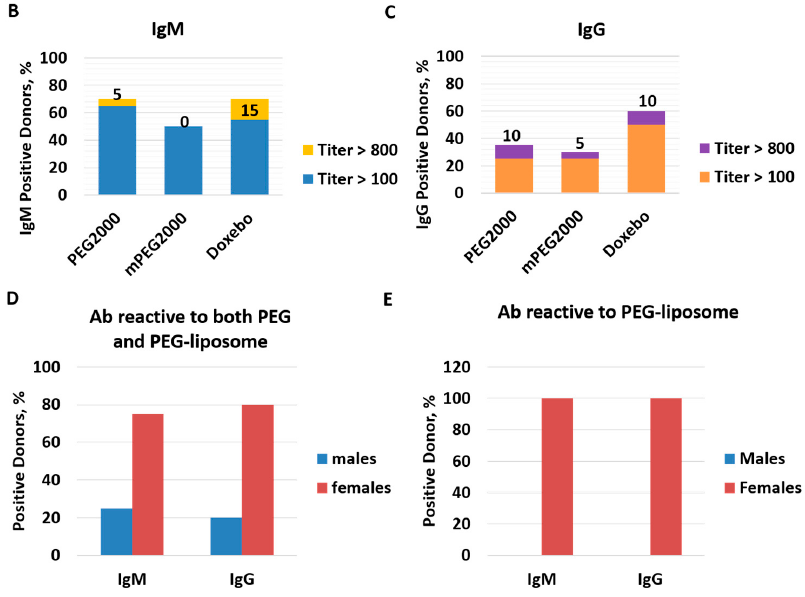
Figure 4. Analysis of pre-existing anti-PEG antibodies in human plasma. Human plasma anticoagulated Analysis of pre-existing anti-PEG antibodies in human plasma. Human with hirudin was collected from 20 healthy donor volunteers and tested in vitro. ( A ) A summary of antibody titers detected in individual donor plasma specimens. Positive controls are monoclonal antibodies as described in the materials and methods. There is no positive control in the PEG2000 IgG assay because currently available anti-PEG IgG are reactive to methoxy group. The titer in all shown PC samples was above 3200. Plasma from each donor was tested in duplicate on four ELISA plates.